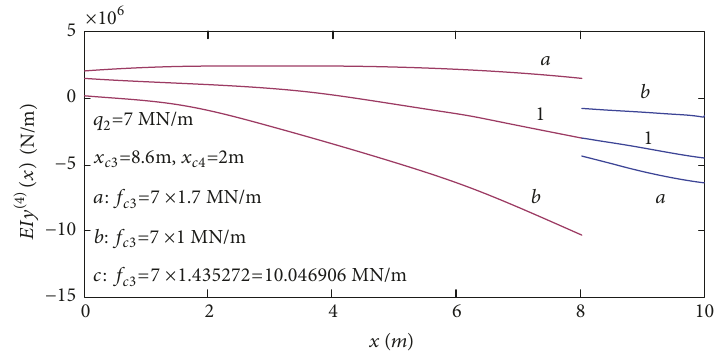
Figure 9: The 𝐸𝐼𝑦 (4) (𝑥) curves at with different 𝑓 c 3 values.